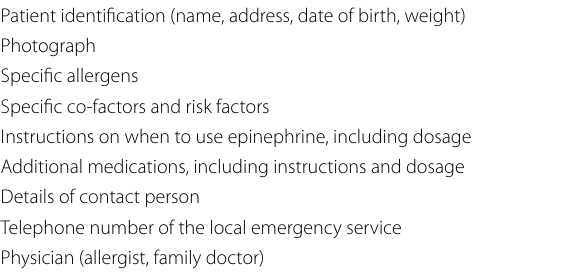
Table 3 Summary of data that should be included in a per- sonalized anaphylaxis emergency action plan